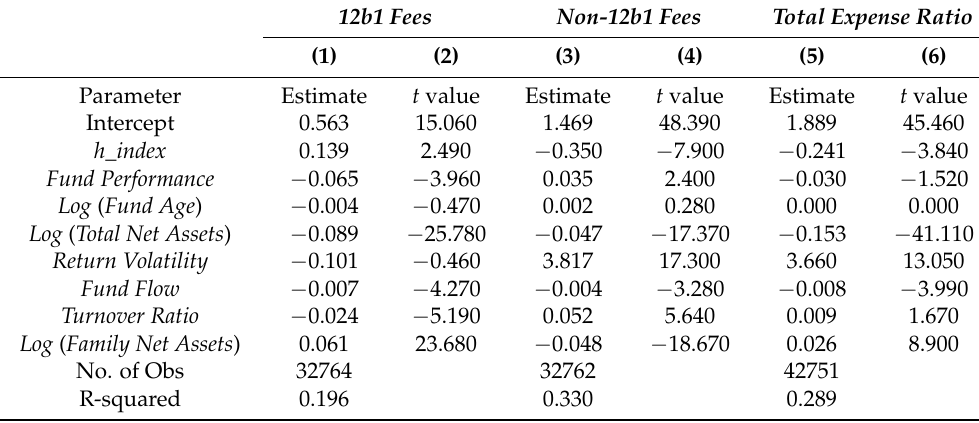
Table 6. The impact of competition on marketing